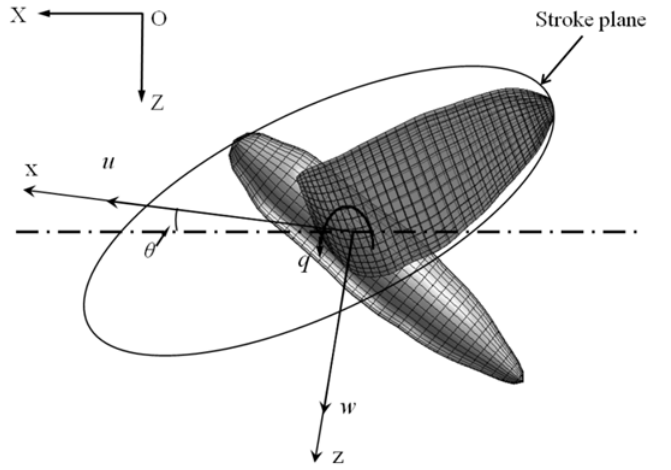
Fig. 2 Definitions of the coordinate systems and the state